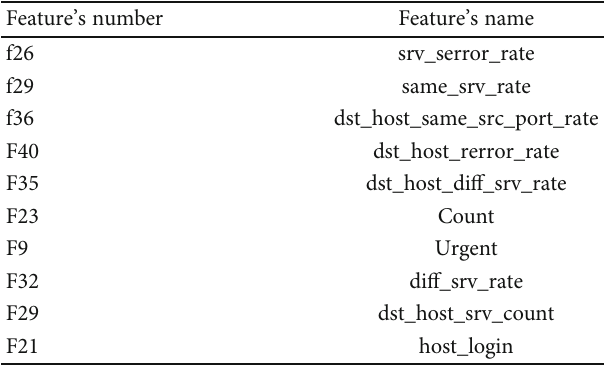
Table 2: Top ranked features of KDD Cup ’ 99 using information gain method.